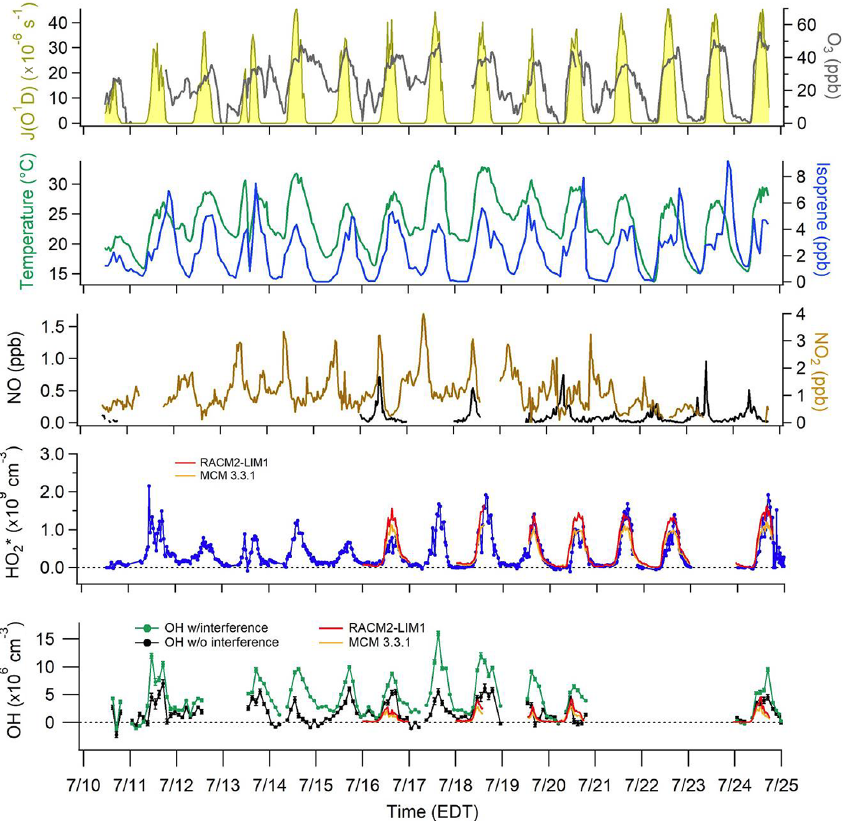
Figure 2. Time series of OH and HO ∗ from 10 to 25 July with model-calculated J ( O 1 D ) scaled to the measured J ( NO 2 ) , and measured 2 ozone, temperature, isoprene, and NO x . OH measurements with interference ( ± 1 σ ) are represented by the green line and measurements without interference ( ± 1 σ ) by the black line. For clarity, OH data shown are 2h averages. HO ∗ data are 30s averages every 30min. The 2 daily RACM2-LIM1 and MCM 3.3.1 model results for the periods when NO was measured simultaneously are also shown.